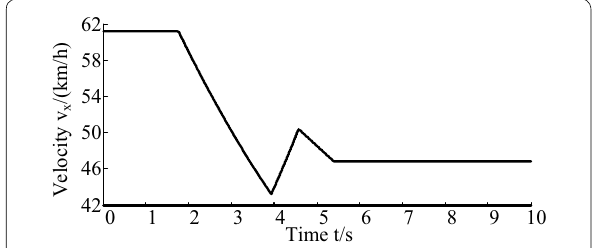
Figure 7 Reference velocities under a time-varying velocity condition